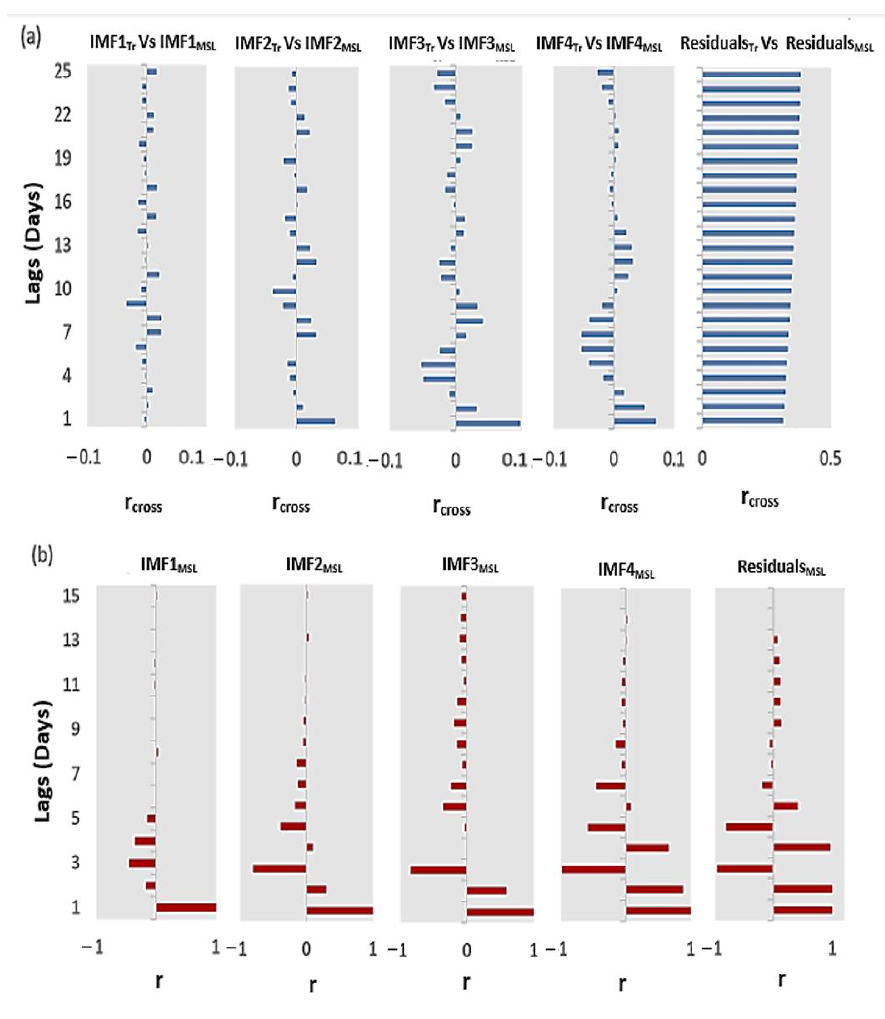
Figure 4. An analysis of the statistically significant cross-correlation function plots of ( a ) IMF(s) and Residuals of Transpiration (Tr) vs. IMF(s) and Residuals of MSL accordingly, ( b ) Partial Auto Correlation Function (PACF) plot of the IMF(s) of MSL time series.